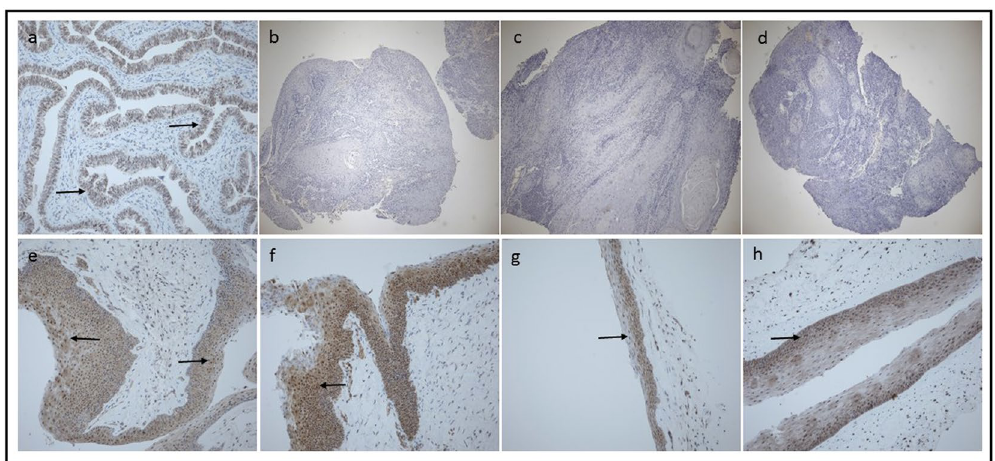
Figure 5. Microphotograph of immunohistochemically stained FAM107A protein in: fallopian tube (control) ( a ), LSCC ( b – d ) and non-tumor controls ( e – h ). Nucleus counterstained with hematoxylin, arrows indicate positive nuclear/cytoplasmic staining (brown), primary objective magnification